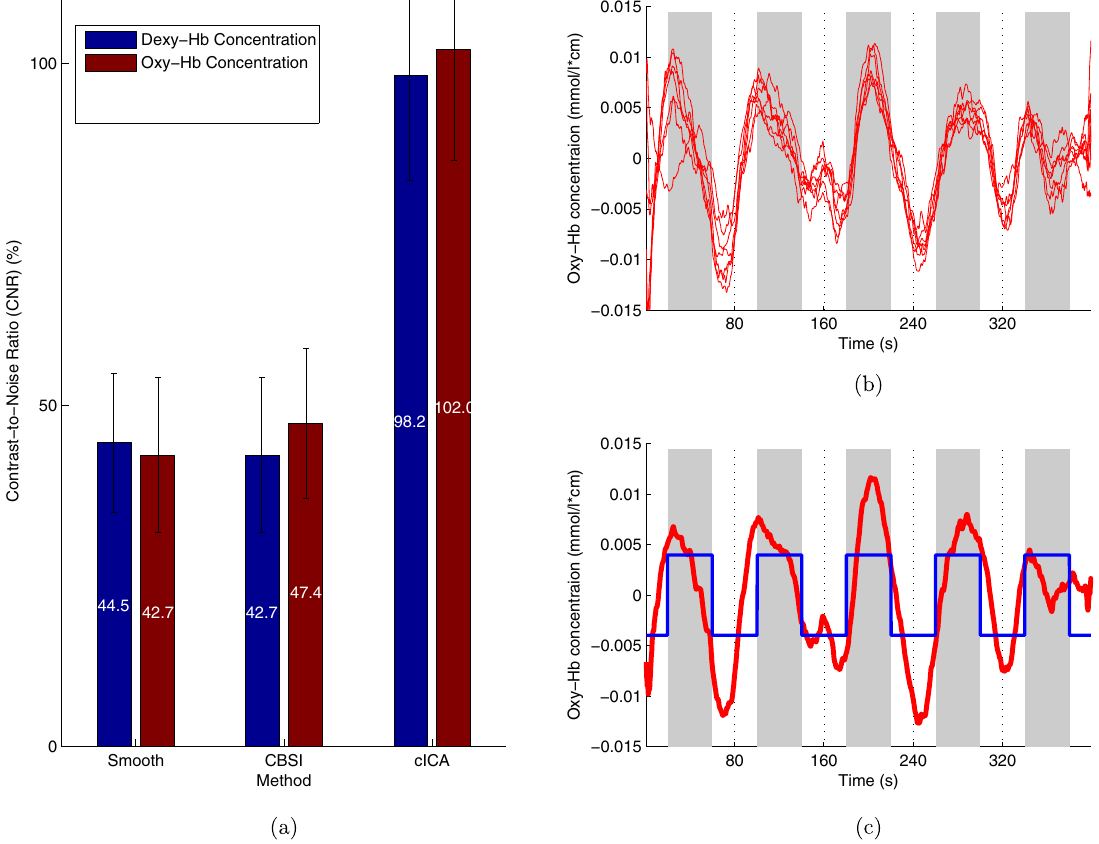
Fig. 7. Improved fNIRS signals using cICA. (a) CNR Comparison of hemoglobin concentration between rest and task of raw fNIRS signals (only smoothing is utilized), fNIRS signals improved by CBSI and cICA, respectively, (b) an example of oxy-Hb concen- tration signals over 7 channels, and (c) an example of oxy-Hb concentration signal extracted from those mixtures by